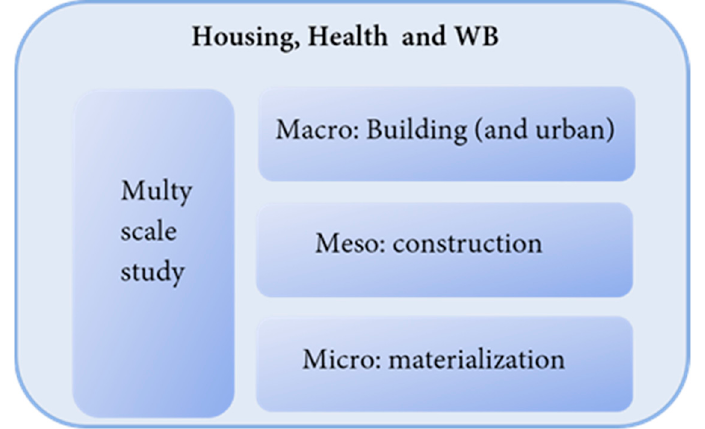
Figure 2. Multiple scales studied in PCSs enhance research on PCMs.